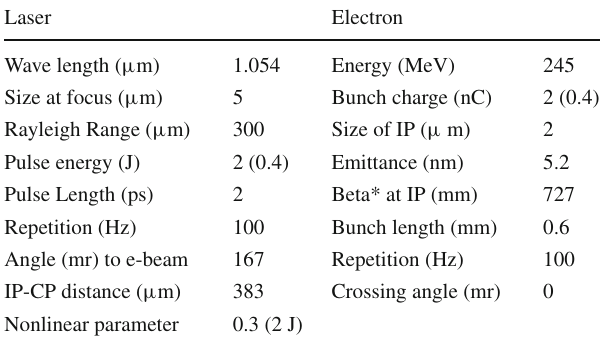
Table 1 Laser and electron beam parameters for the proposed γγ